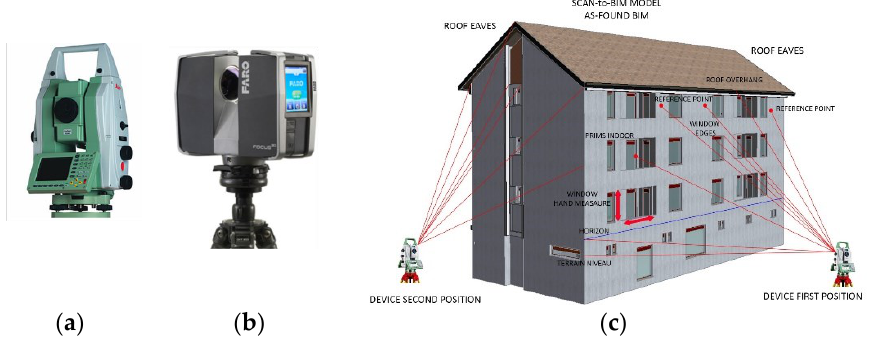
Figure 5. Three-dimensional survey tools used for the research case study: ( a – c ) total station; ( b ) laser scanner.